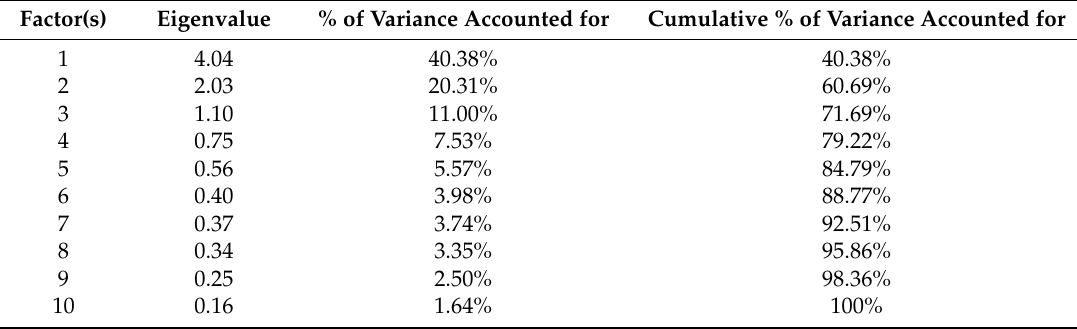
Table 2. Religious orientation: eigenvalues and their percentages of variance accounted for.